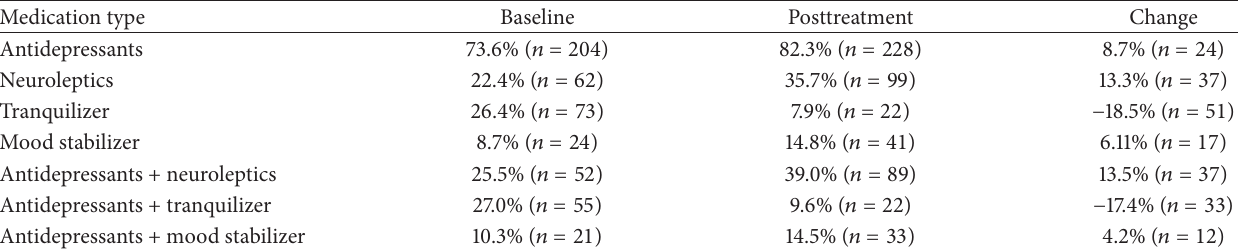
Table 1: Frequencies and changes in medications used over the course of treatment.